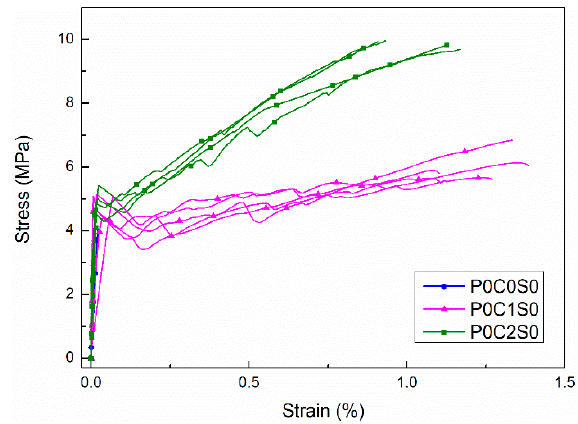
Figure 7. Stress–strain curves of the test specimens: P0C0S0, P0C1S0, and P0C2S0.